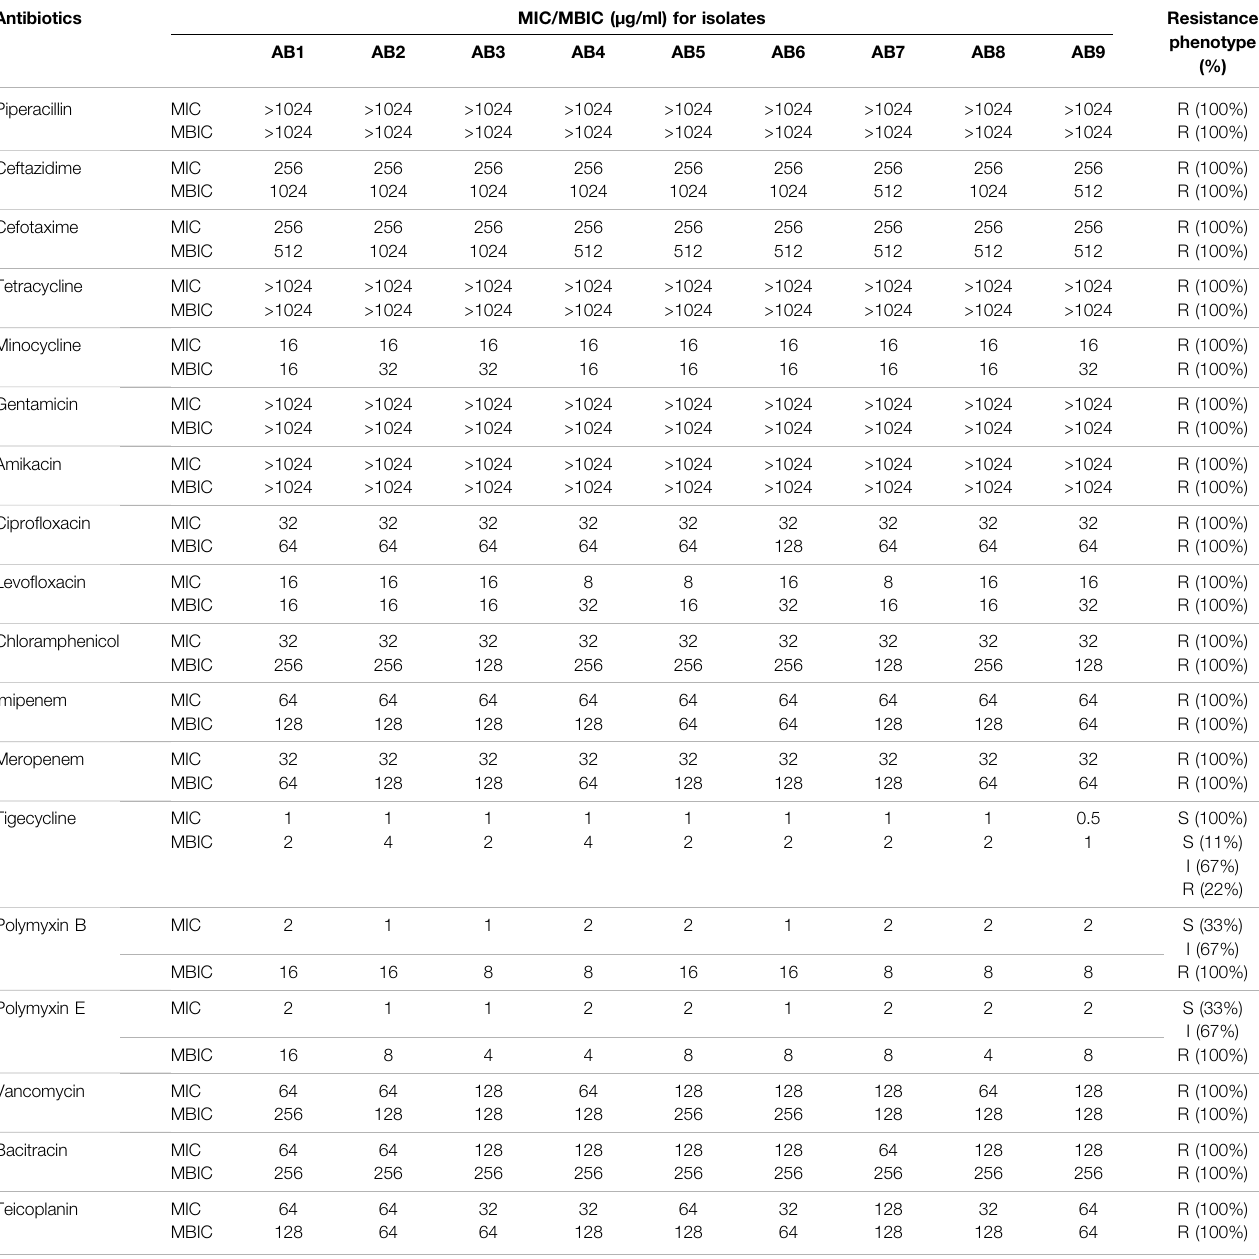
TABLE 1 | Minimum inhibitory concentrations (MICs) and Minimum bio fi lm inhibitory concentrations (MBICs) of 15 antibacterial agents with fi ve peptide antibiotics against nine clinical isolates of A. baumannii. Antibiotics MIC/MBIC ( μ g/ml) for isolates Resistance